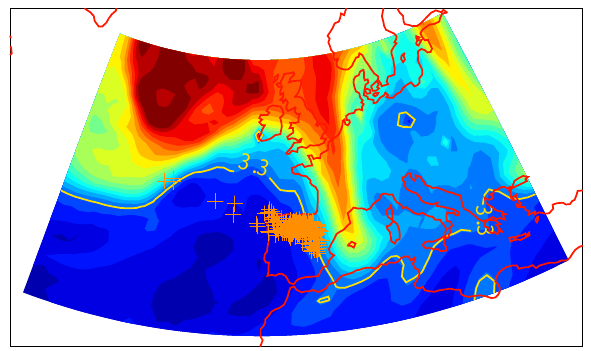
Fig. 8. MPV on the 340 K isentrope on 2 September 1997 at 14:00 UTC. Crosses indicate the location where the rays crossed that isen- trope, after advection until this time with the displacement speed of the flow in the upper-troposphere lower-stratosphere (see